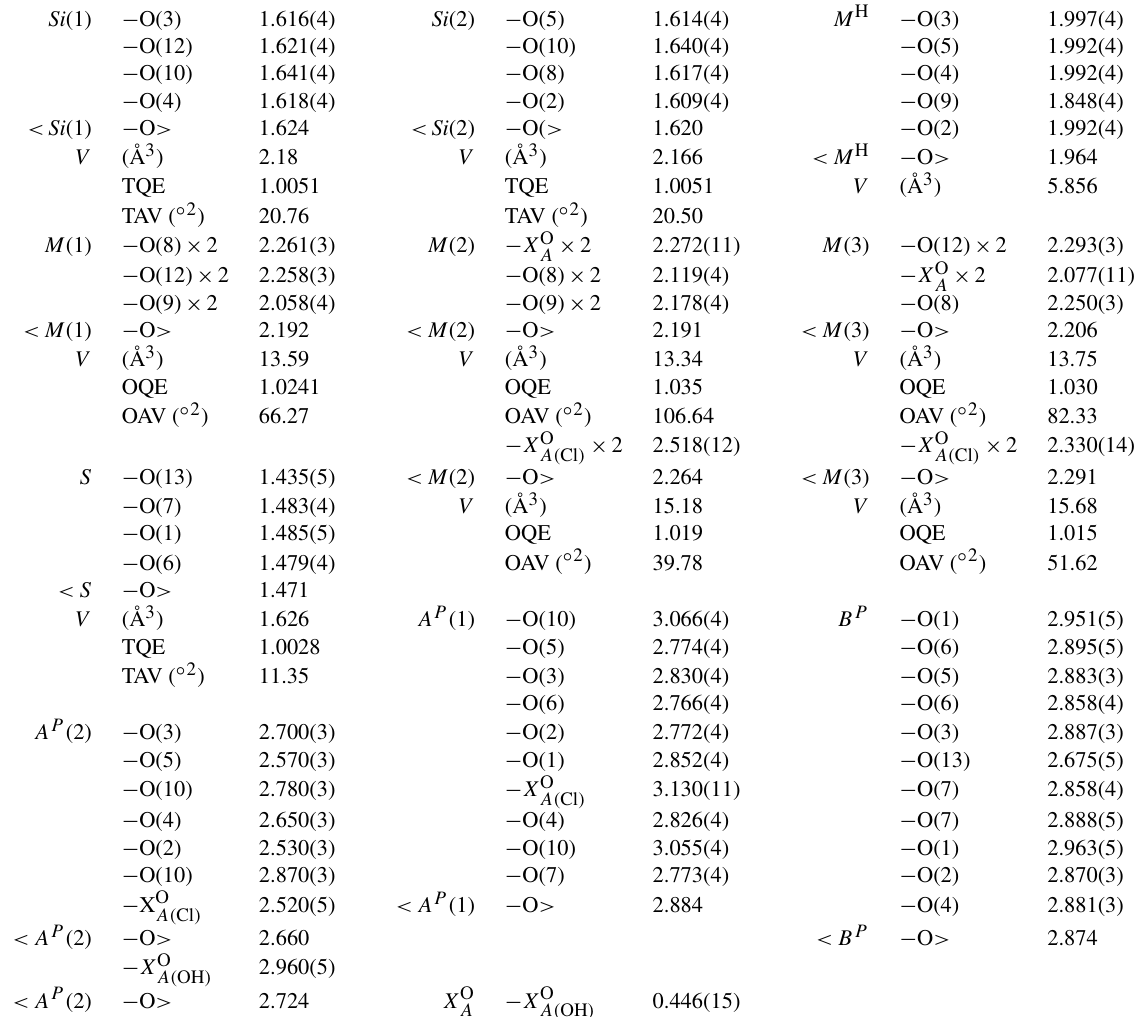
Table 7. Selected interatomic distances (Å), polyhedral volumes and polyhedral distortion parameters for